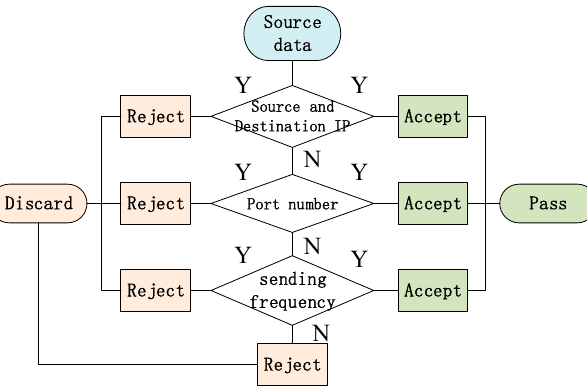
Figure 7. Principles of firewall with access control list.